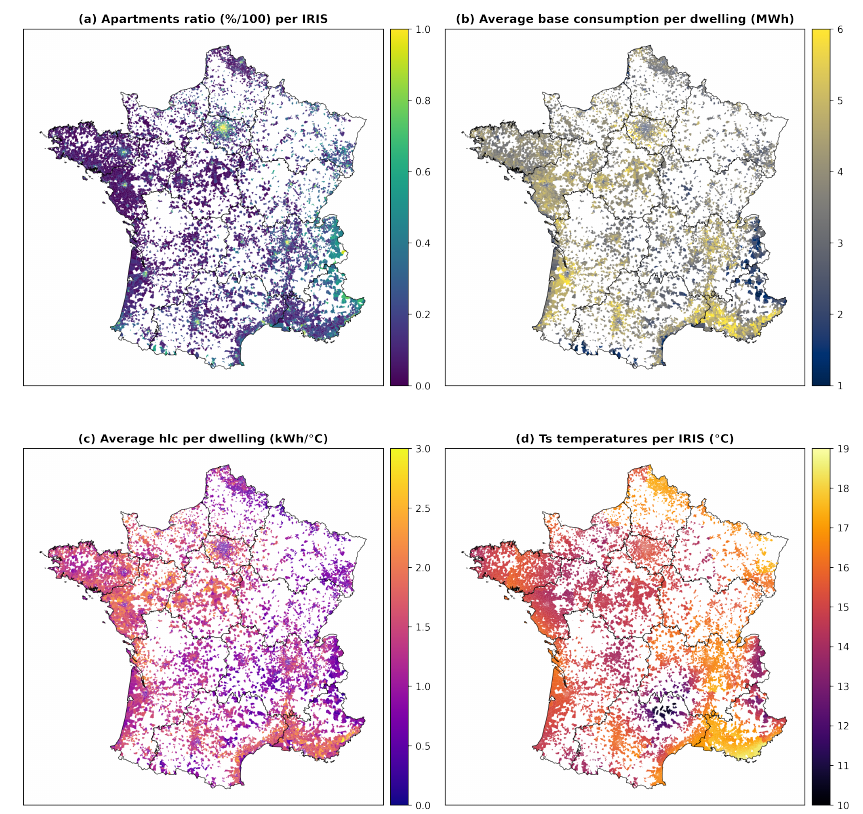
Figure 3. Geographical disposition of used IRIS and related 2017 values for ( a ) apartments ratio per IRIS ( b ) average hlc per dwelling ( c ) average base consumption per dwelling, and ( d ) computed T s per IRIS. White areas are for missing